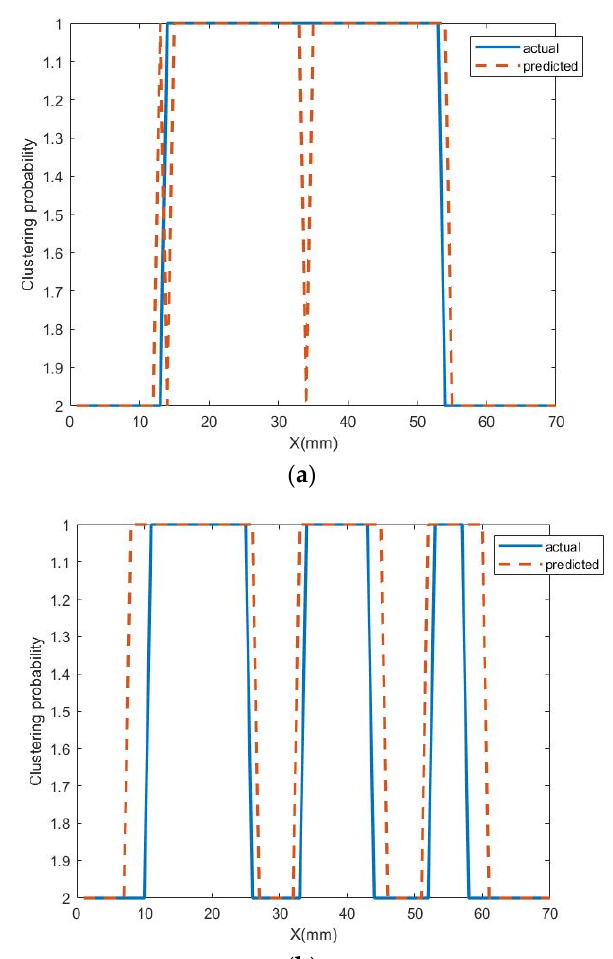
Figure 14. A juxtaposition among both the grouping outcomes to the real position and extent of the Macor sample ( a ) 25 × 20 mm defects, ( b ) 15 × 15 mm, 10 × 10 mm, and 5 × 5 mm defects.